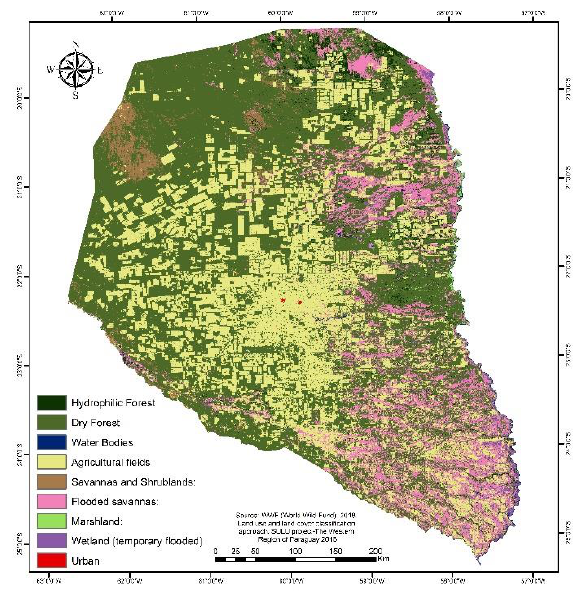
Figure 2. Land Use, land cover of the Western Region of Paraguay.